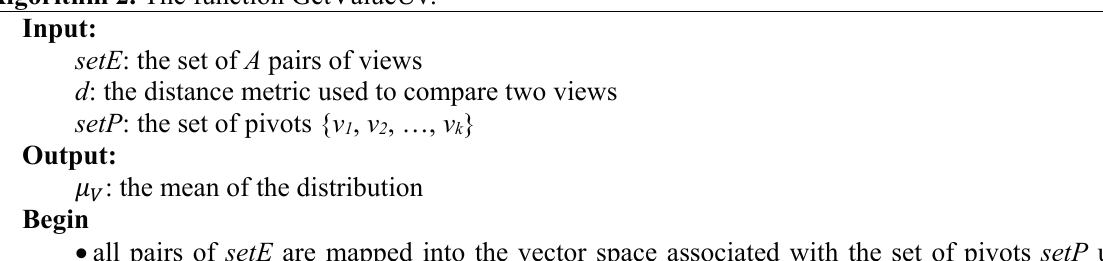
Algorithm 2. The function